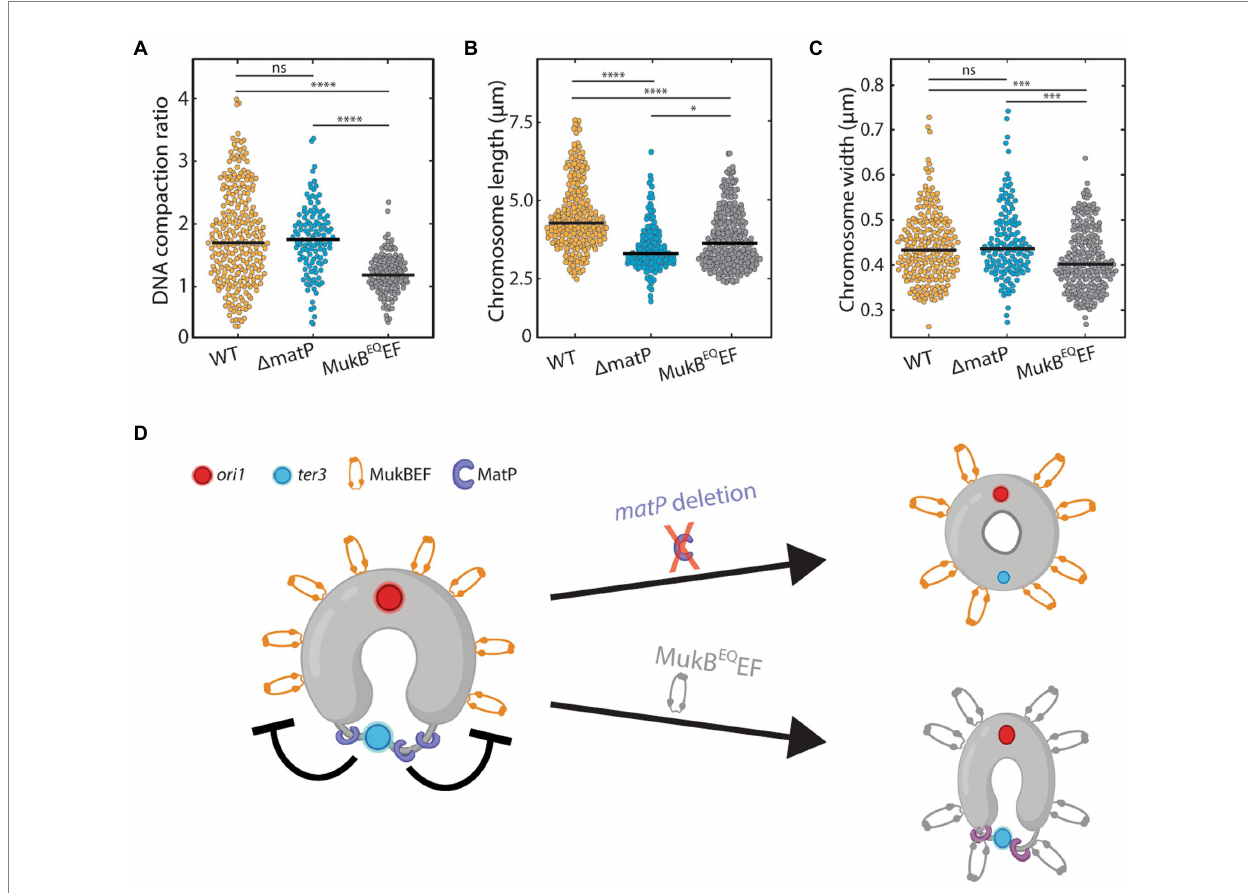
FIGURE 3 The effect of MukB on chromosome shape and compaction. (A) Ratio of DNA density in the regions where MukB localizes versus elsewhere along the chromosome for wildtype ( N = 260 cells), Δ matP ( N = 121 cells), and MukB EQ EF mutants ( N = 131 cells). (B) Chromosome length distribution for wildtype ( N = 222 cells), Δ matP ( N = 153 cells) and MukB EQ EF mutants ( N = 226 cells). (C) Chromosome width distribution for wildtype ( N = 222 cells), Δ matP ( N = 153 cells) and MukB EQ EF cells ( N = 226 cells). (D) Schematics depicting the circular nucleoid of E. coli with the position where MatP (purple) binds and a flexible decondensed terminus region (thin gray line). MukBEF is positioned away from the terminus near the origin of replication. Statistical significance was determined by performing a single factor ANOVA test. The following conventions are used: ns: 0.05 < p , *: 0.01 < p < 0.05, ***: 0.0001 < p < 0.001, ****: p < 0.0001. We report a significant difference in results if p <